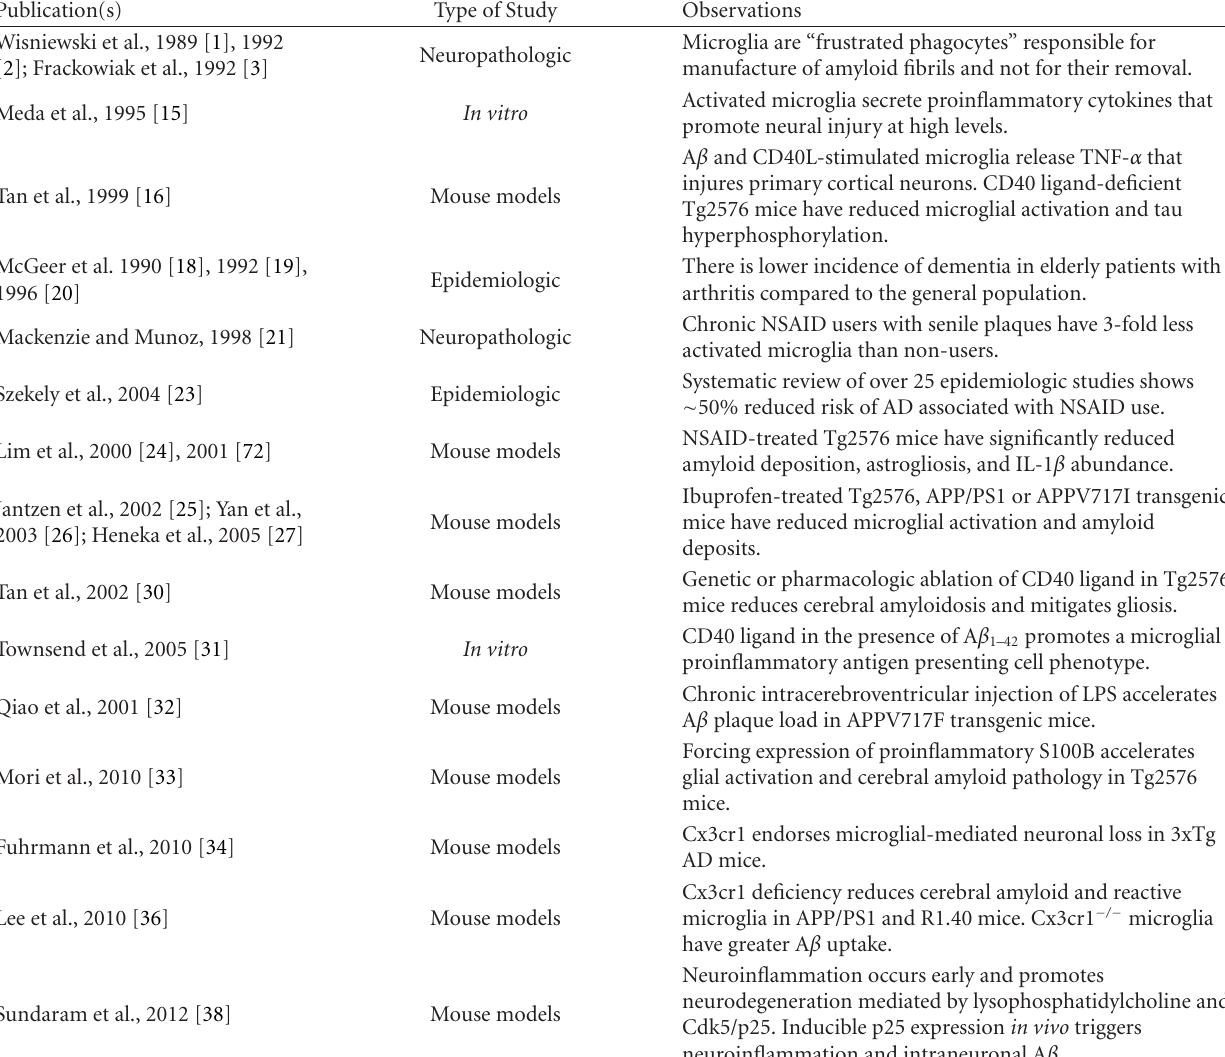
Table 1: “Bad” microglia in Alzheimer